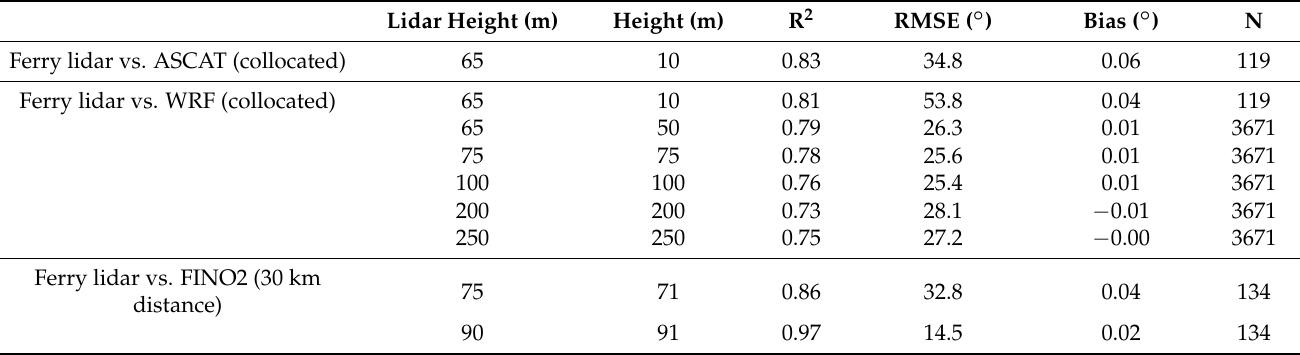
Table 4. Ferry lidar validation statistics (bias, RMSE, correlation) of wind direction with ASCAT, WRF, and FINO2. Lidar Height